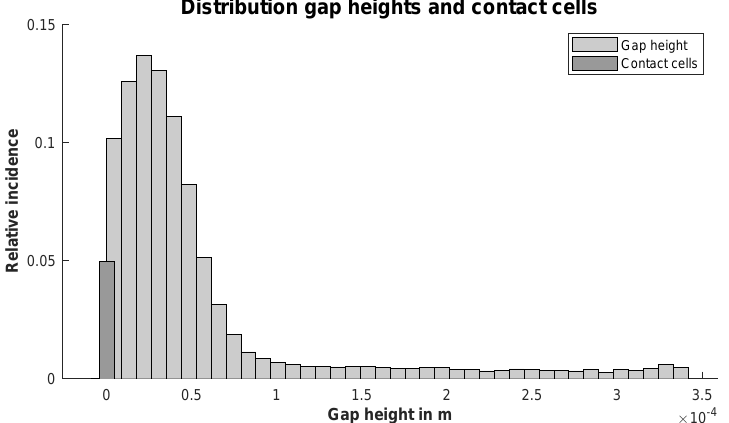
Figure 18. Distributions of deformed gap heights in the sidewards-facing